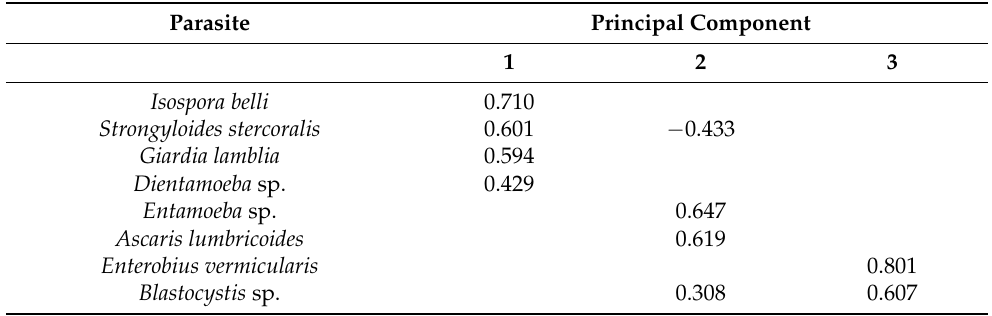
Table 3. Rotated component matrix: loadings of principal components 1, 2 and 3 on variables related to the absence/presence of pathogens. Coefficients below 0.3 (absolute value) have been suppressed for easier